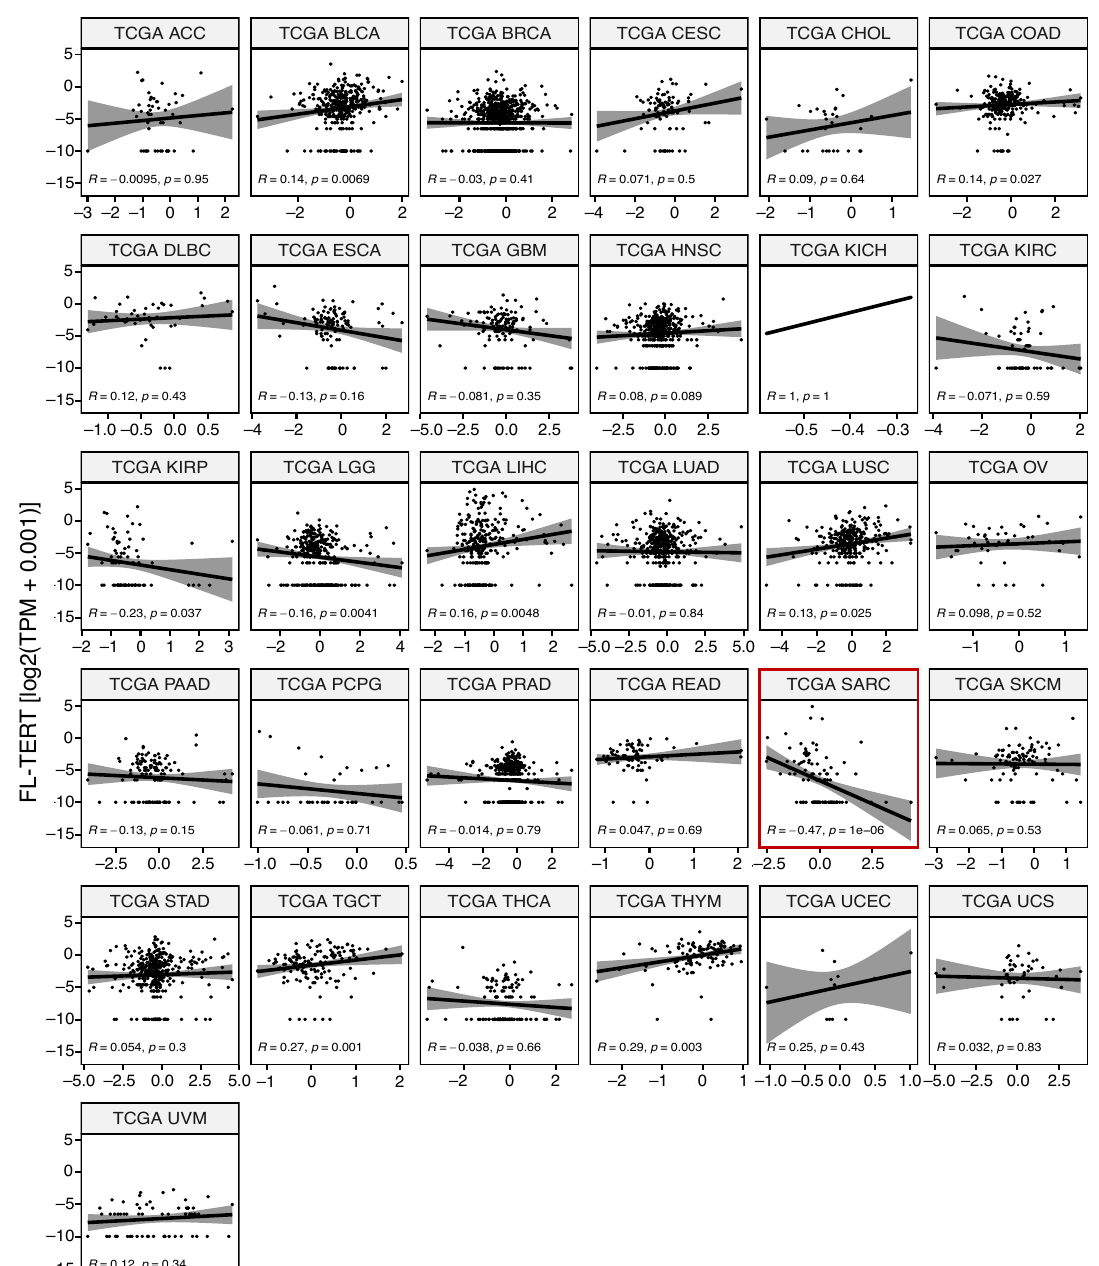
Figure 5. FL-TERT isoform expression has a significant negative correlation only with telomere length ratio in sarcomas. Only SARC had significant correlation, which was negative. Telomere length ratios and FL-TERT expression were log 10 and log 2 (TPM + 0.001) transformed, respectively. Scatter plots were fitted with a linear regression line and 95% confidence interval. Spearman correlations were computed, and significance determined using a Bonferroni corrected p -value of <0.000230 (0.05/217 comparisons). Significant correlations are highlighted with a red border.